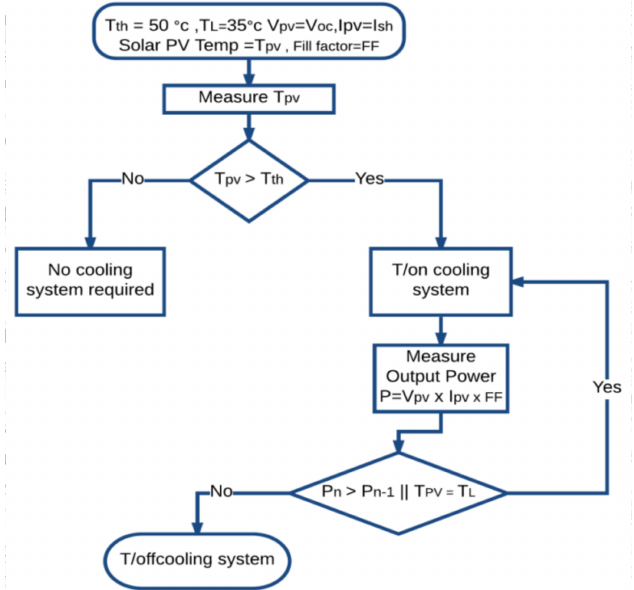
Figure 7. Optimal control algorithm developed for